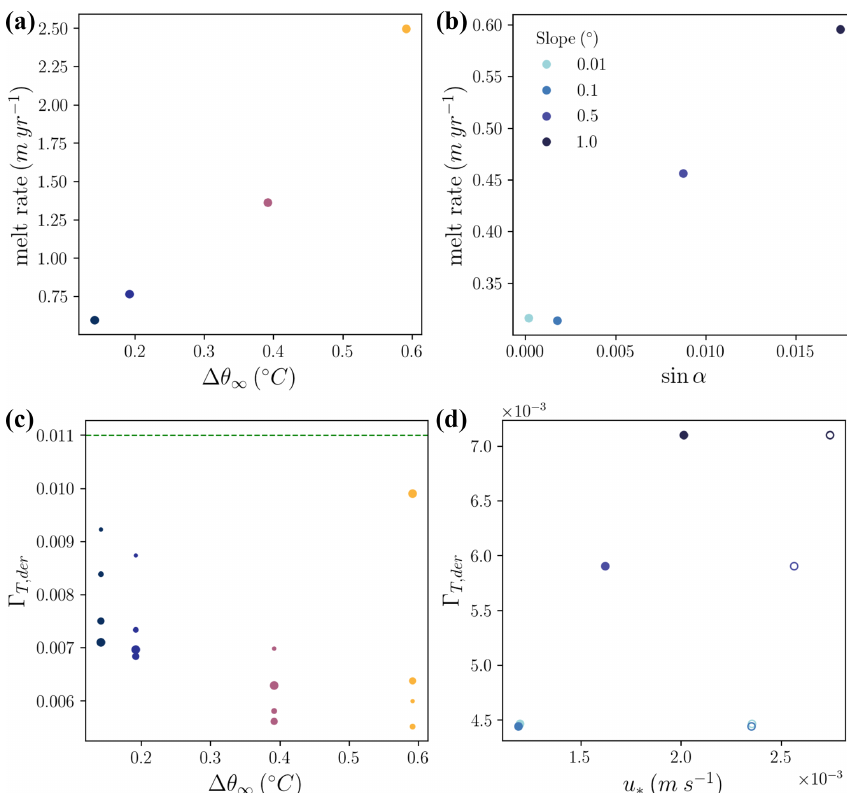
Figure 8. Melt rate sensitivity to (a) far-field thermal driving and (b) sine of the basal slope. (c) Far-field thermal driving is inversely related to (cid:48) T , der . Dashed line denotes the value recommended by Jenkins et al. (2010). The largest points correspond to the fourth inertial cycle with progressively smaller points for previous inertial cycles. (d) For variations in slope, the simulated friction velocity (solid points) is linearly related to (cid:48) T , der . The inferred friction velocities used to compute (cid:48) T , der are shown with open points. Note the difference in y -axis limits from (c) . The 0.01 and 0.1 ◦ slope cases are